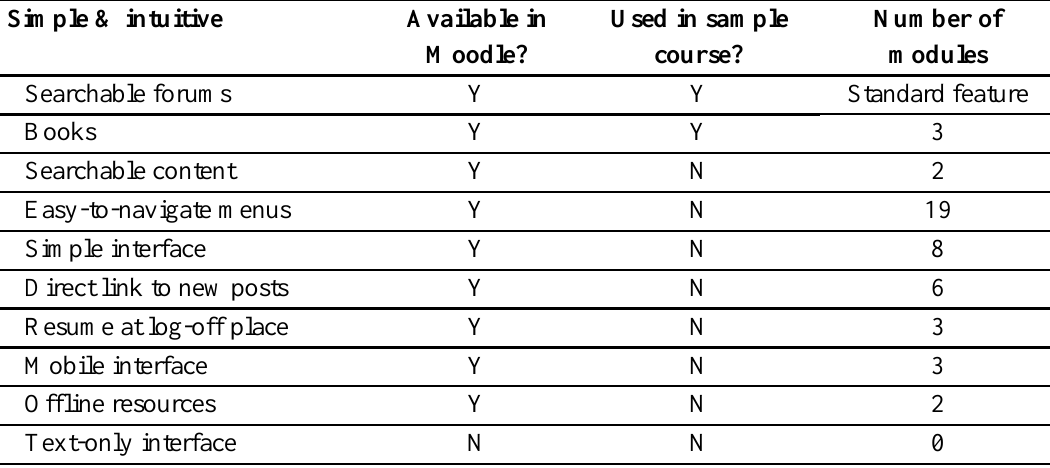
Availability of Moodle Modules Serving the Simple and Intuitive Principle Simple &